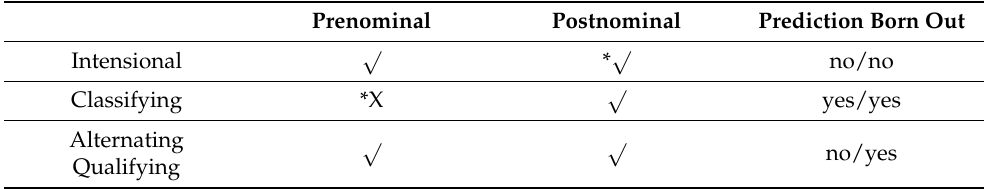
Table 7. Convergence predictions according to adjective type and position with